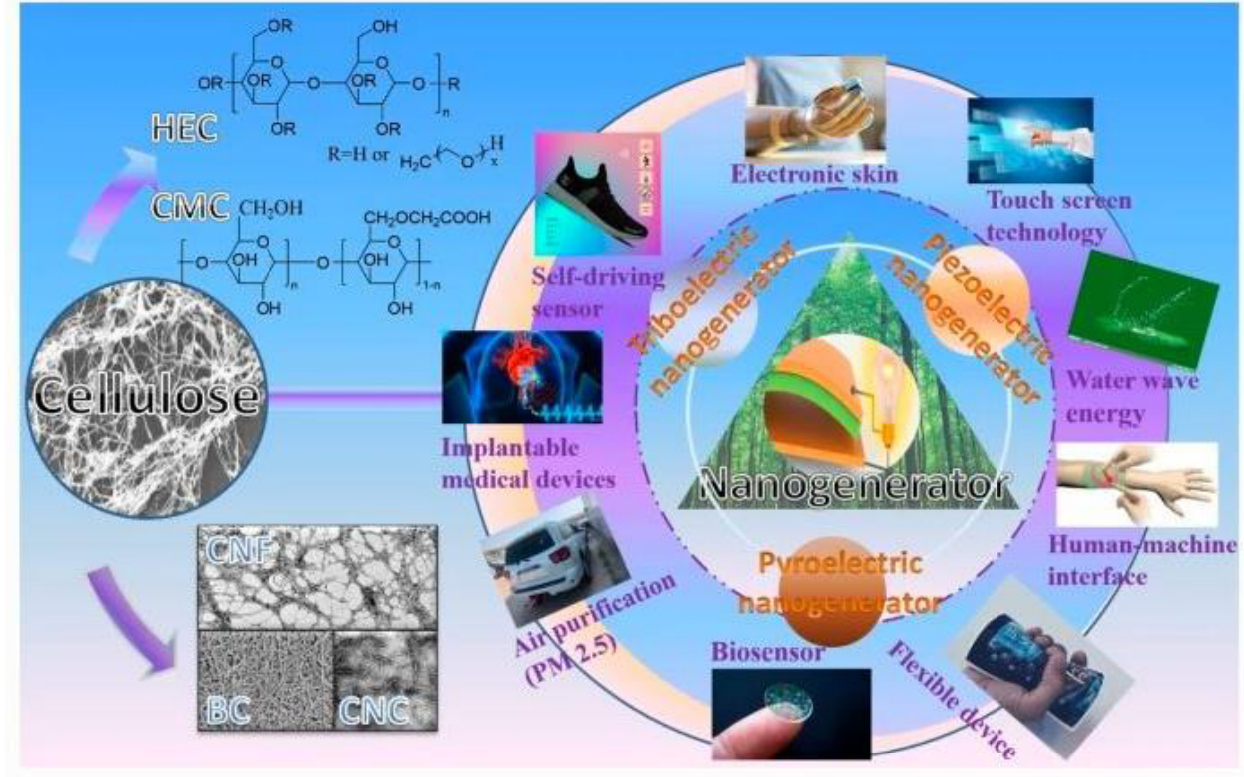
Figure 6. Recent strategies and advances in cellulose and its applications were comprehensively reviewed.